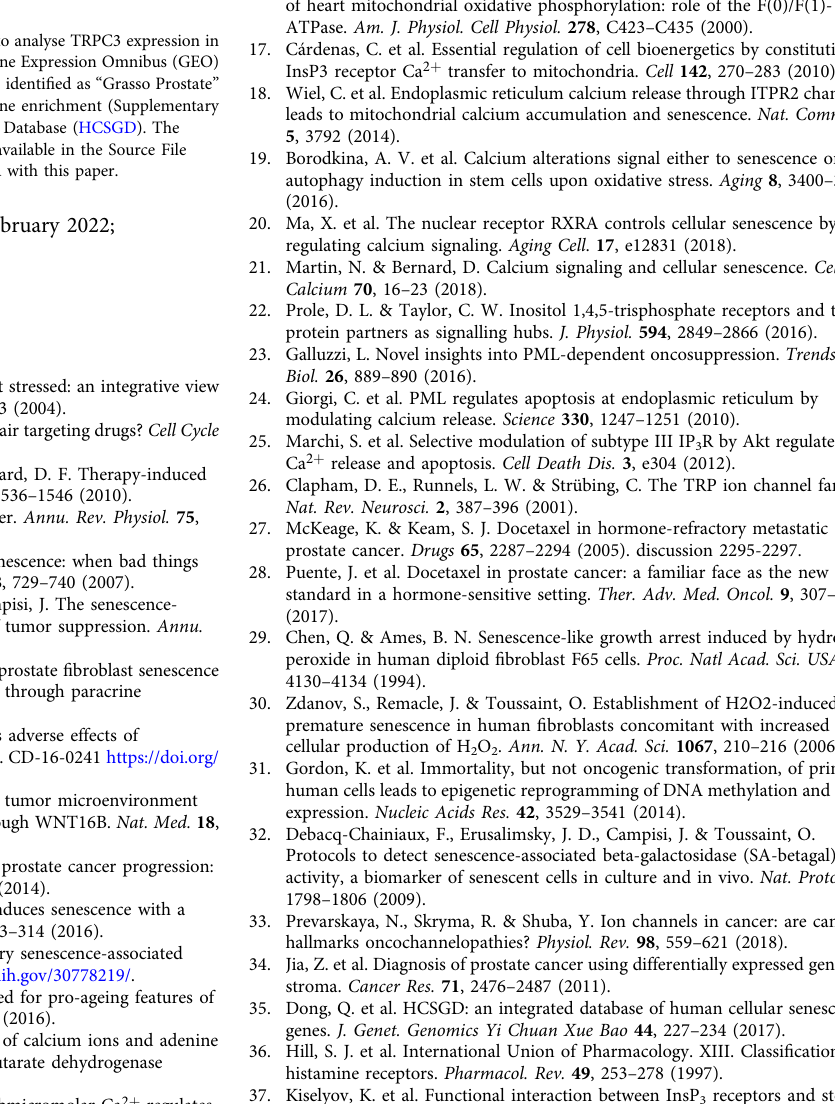
Fig. 8 TRPC3 knockdown-induced senescence is responsible for the pro-tumour behaviour of prostate stromal cells. a Heatmap showing the log2 fold change in secreted SASP, as revealed by antibody arrays, by CAFs treated with siTRPC3 and compared to siCTL cells ( n = 3, multiple T -test, two-sided, Holm – Sidak correction for multiple comparisons). b Bar diagram plot comparing cell proliferation measured with MTS proliferation assay in PC3 (left) and DU145 (right) cell lines cultured in: (1) non-conditioned medium (NCM), (2) conditioned medium from the siCTL-transfected CAFs (CAFs siCTL CM) and (3) conditioned medium from the siTRPC3-transfected CAFs (CAFs siTRPC3 CM). The readings (light absorption) from PC3 or DU145 cells obtained in CAFs siCTL CM and CAFs siTRPC3 CM were normalised to corresponding readings obtained in NCM and expressed as % (mean ± SEM, n = 3: one-way ANOVA, Tukey ’ s multiple comparisons test). c Same as in ( b ) but illustrating cell lines cultured in conditioned medium from: (1) control cells, (2) hRAS- overexpressing cells (hRAS), (3) hRAS + TRPC3-overexpressing cells or (4) cells overexpressing TRPC3 alone (mean ± SEM, n = 3: one-way ANOVA, Tukey ’ s multiple comparisons test). d Bar diagram plot comparing survival of PC3 and DU145 cells (as indicated) after docetaxel treatment between the cell groups described in ( b ). The same measurements were done on the cells exposed to DMSO (vehicle) instead of docetaxel. Chemotherapy-resistance was expressed as a ratio of the cell survival observed after treatment with docetaxel to that observed with vehicle only and expressed in % (mean ± SEM, n = 3: one-way ANOVA, Tukey ’ s multiple comparisons test). e Time course (6 weeks) of the bioluminescence mean (10 mice; ±SD) total fl ux (top) and underlying individual traces (bottom) obtained 15 min after luciferin administration. The mice, continuously admitting doxycycline, were injected with PC3- Luc cells mixed with either siCTL-transduced (black line) or siTRPC3#1-transduced (red line) HPrFs. *** P < 0.001, ** P < 0.01 (one-way ANOVA, Tukey ’ s multiple comparisons test). f Bioluminescence images of oxidised luciferin from 3 mice of the two groups (panel e ) on the 6th week after tumour challenge. g Comparison of sizes from tumours collected 6 weeks after tumour challenge. Scale bar: